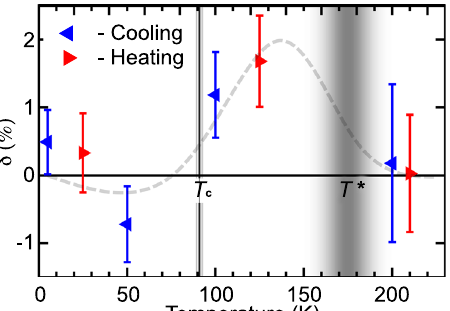
Fig. 3 Temperature dependence of the anisotropy parameter δ . δ is de fi ned by Eq. (2). The values have been determined by fi tting Eq. (2) to the constant-energy-surface mappings in Fig. 2. The error bars are standard errors of the fi tting parameter at each temperature. The dashed gray line is a guide to the